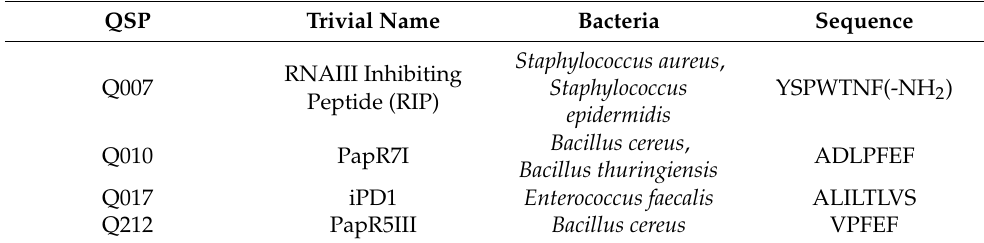
Table 1. Four QSPs with the highest inflammatory